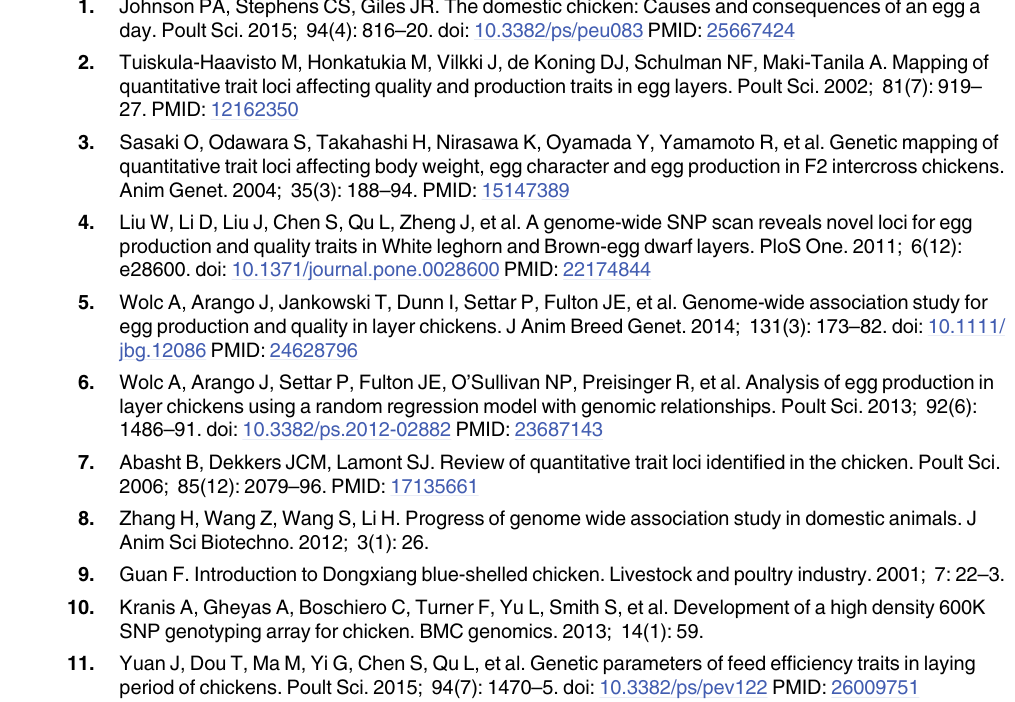
S7 Table. SNPs showing genome-wise significance of suggestive association ( P - value < 1.69e-5) with age at first egg. 1 : Chicken chromosome. 2 : first listed marker is minor allele. 3 : minor allele frequency. 4 : allele substitution effect. 5 : U and D indicates that the SNP is upstream and downstream of the gene. (XLSX).